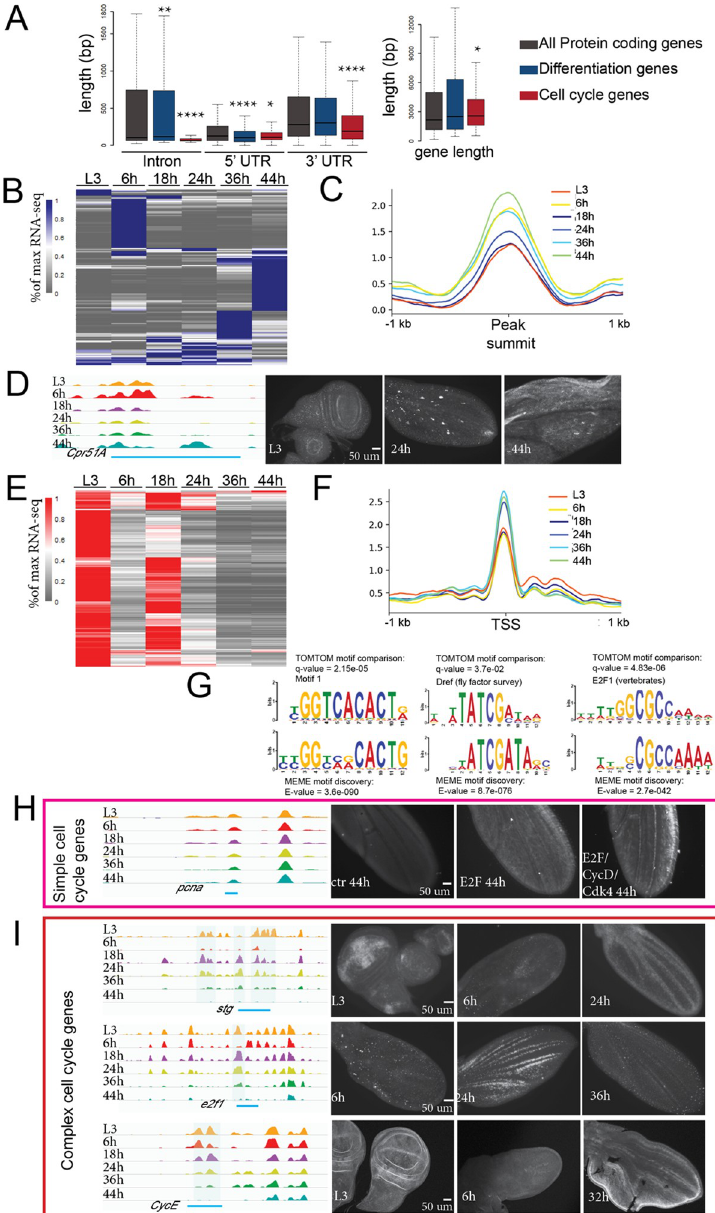
Fig 2. Temporal regulation of the wing differentiation program and cell cycle changes. (A) The length (in bp) of introns, 5 0 UTRs, and 3 0 UTRs (left) and genes (right) for all protein coding genes, wing terminal differentiation genes, and cell cycle genes is shown. The majority of FAIRE peaks occur within introns (S2 Fig). Most cell cycle genes have a compact structure with few, short introns, whereas differentiation genes contain large introns, providing potential dynamic regulatory elements. (B, E) Heatmap of gene expression for differentiation genes (B) and cell cycle genes (E), plotted by the percent of maximum RNA rpkm value. Both groups of genes show dynamic expression during metamorphosis. (C, F) Line plots of average FAIRE signal of the six stages for differentiation genes (C) and cell cycle genes (F). Differentiation genes show an increase in FAIRE peak accessibility at time points when gene expression is high: 6 h ( p -value = 0.0004088), 36 h ( p -value = 1.36 × 10 − 7 ), and 44 h ( p -value = 1.408 × 10 − 12 ), compared with L3, Mann-Whitney U Test). Cell cycle genes show an increase in accessibility at time points when gene expression is repressed: 24 h ( p -value = 0.0209), 36 h ( p -value = 1.655 × 10 − 5 ), and 44 h ( p -value = 0.005469), Mann-Whitney U Test. (D) A Gal4 reporter containing the indicated (blue bar) portion of the Cpr51A regulatory region drives UAS-GFP in late wings (44 h) when the regulatory elements are accessible. (G) Motif discovery was performed on open regions for cell cycle genes using MEME and compared with known motifs using TOMTOM. Potential regulatory elements for